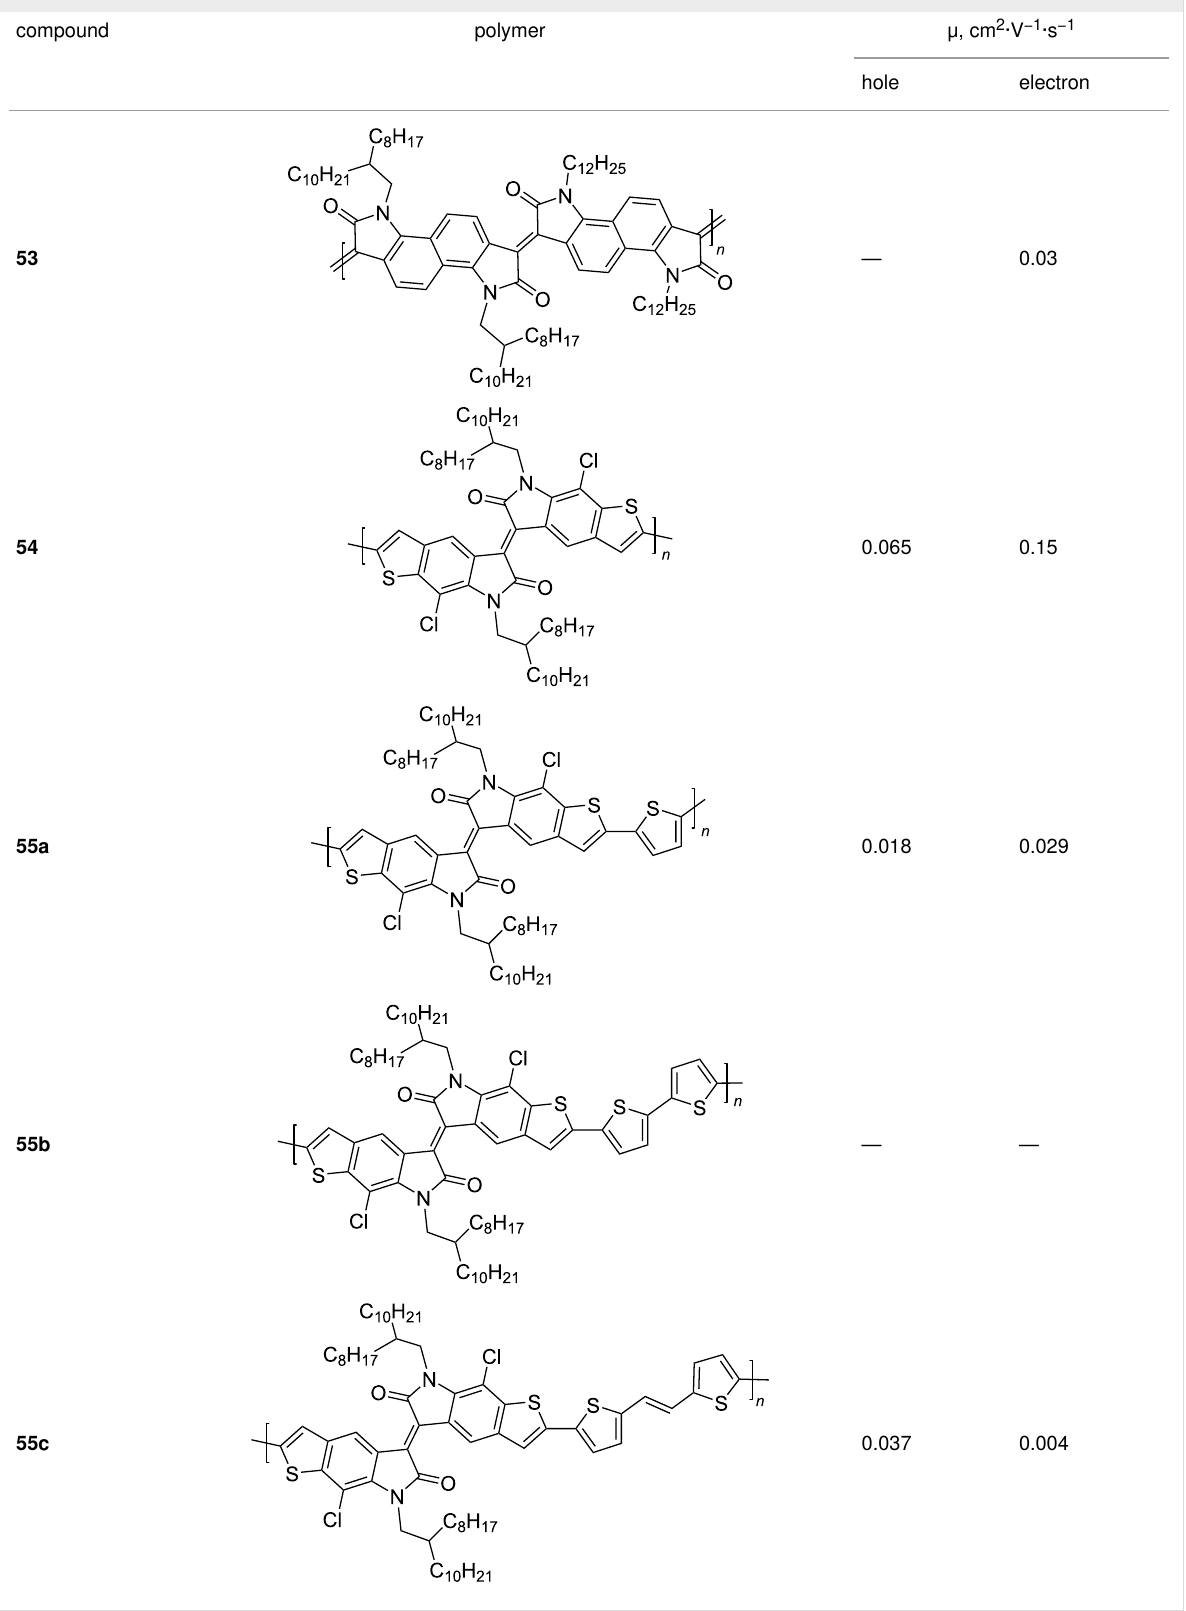
Table 8: Transistor characteristics of homopolymers 53 – 55 . a